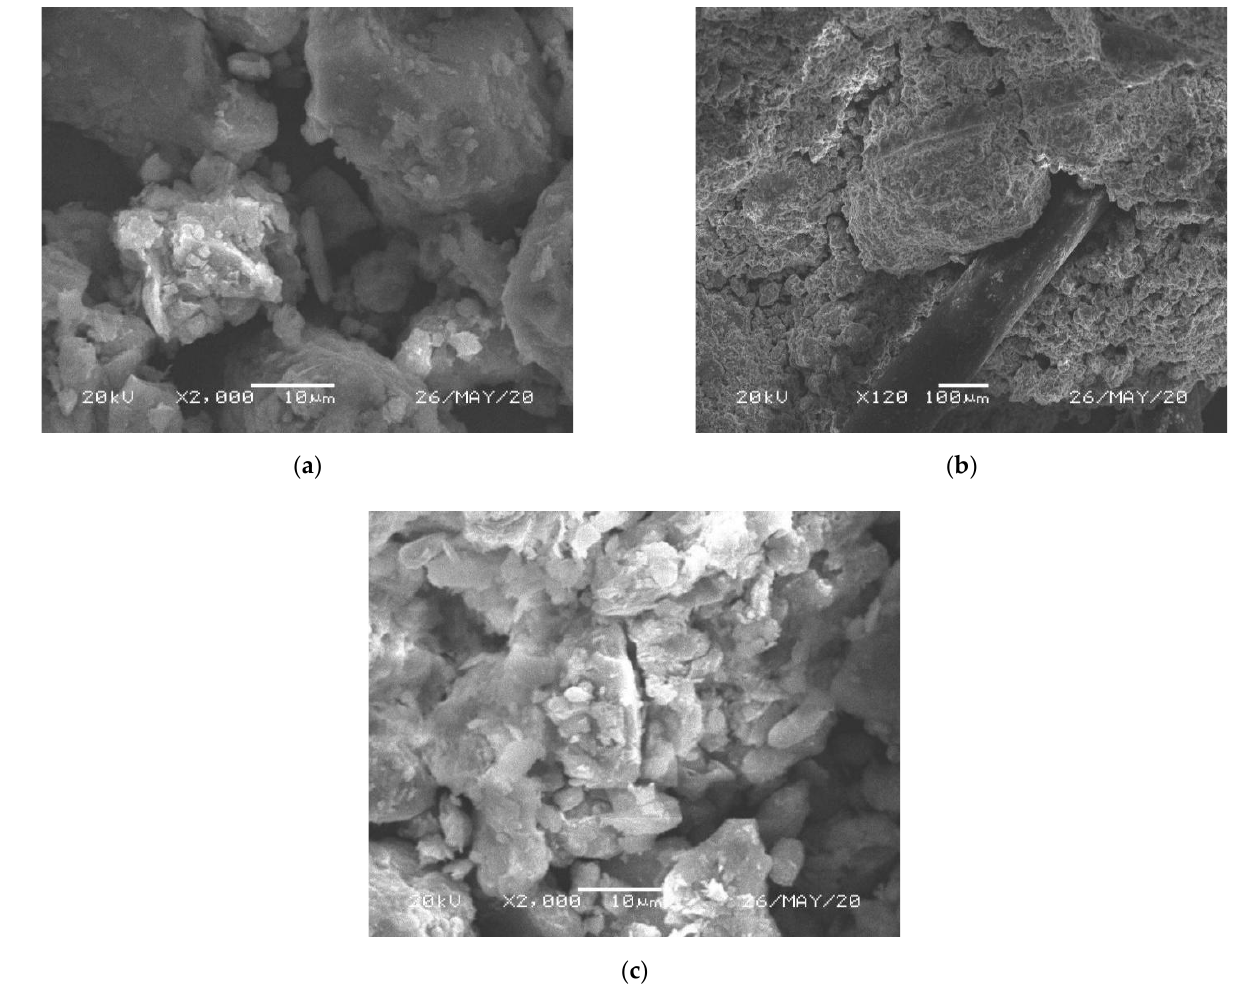
Figure 4. SEM images of modified soil samples. ( a ) LS sample; ( b ) PLS sample; ( c ) FLS sample.